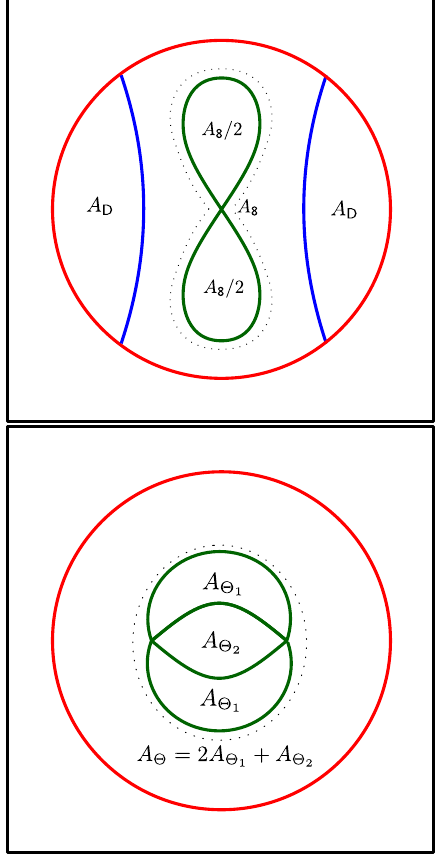
FIG. 2. Definition of the names of the various phase-space ffiffiffiffiffi ffiffiffiffiffi p p 2 J 2 J regions in coordinates ð cos ϕ ; sin ϕ Þ , corresponding to the topologies, shown in Fig. 3, G (top plot) and C (bottom plot). Note that the area of the allowed circle, i.e., the region inside the red circle, is indicated by A ac . The nomenclature has been introduced in Sec. II